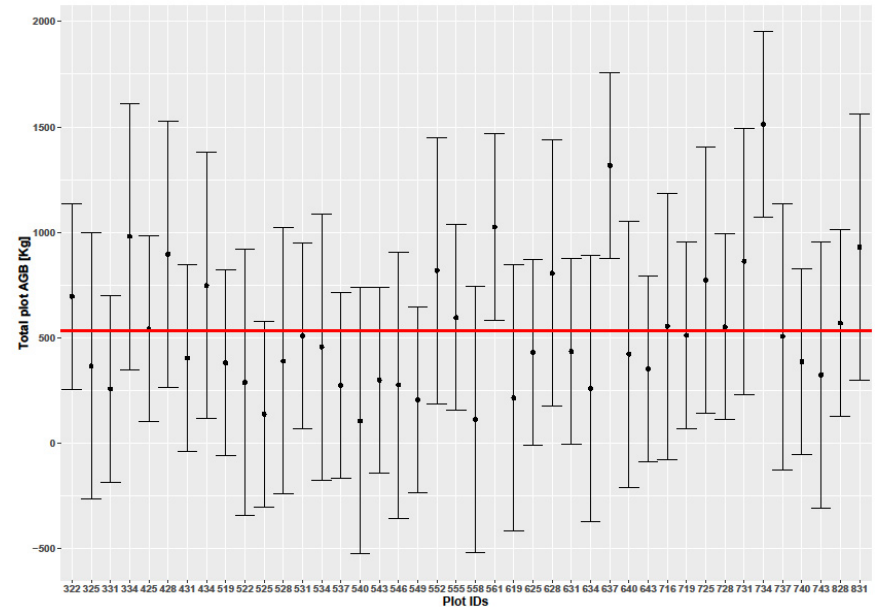
Figure 7. Tree height, diameter, and the resultant AGB per inventoried tree within the study area.